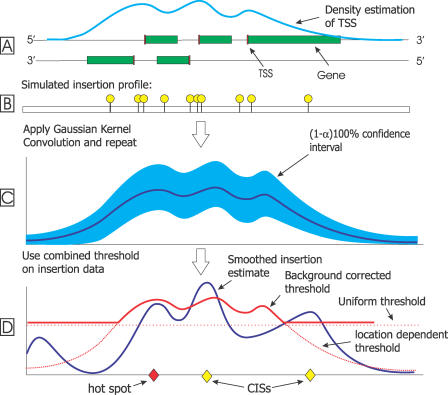
Schematic Depiction of the Computation of a Background-Corrected Threshold(A) The density of TSSs (the 5′ ends of the genes) is computed using a fixed kernel width h
bg.(B) A new realization of insertions is generated using the density from step A.(C) The GKC method is applied to the resulting insertion profile, yielding one realization of the background density estimate. Steps (A) and (B) and applying the GKC are repeated N times to yield a distribution of background realizations. For every position on the genome, a CDF of these realizations is computed and the threshold is determined based on the α-level.(D) The location-dependent threshold is combined with the threshold based on uniform background. Finally, the smoothed insertion estimate of the real data is thresholded with the resulting threshold.